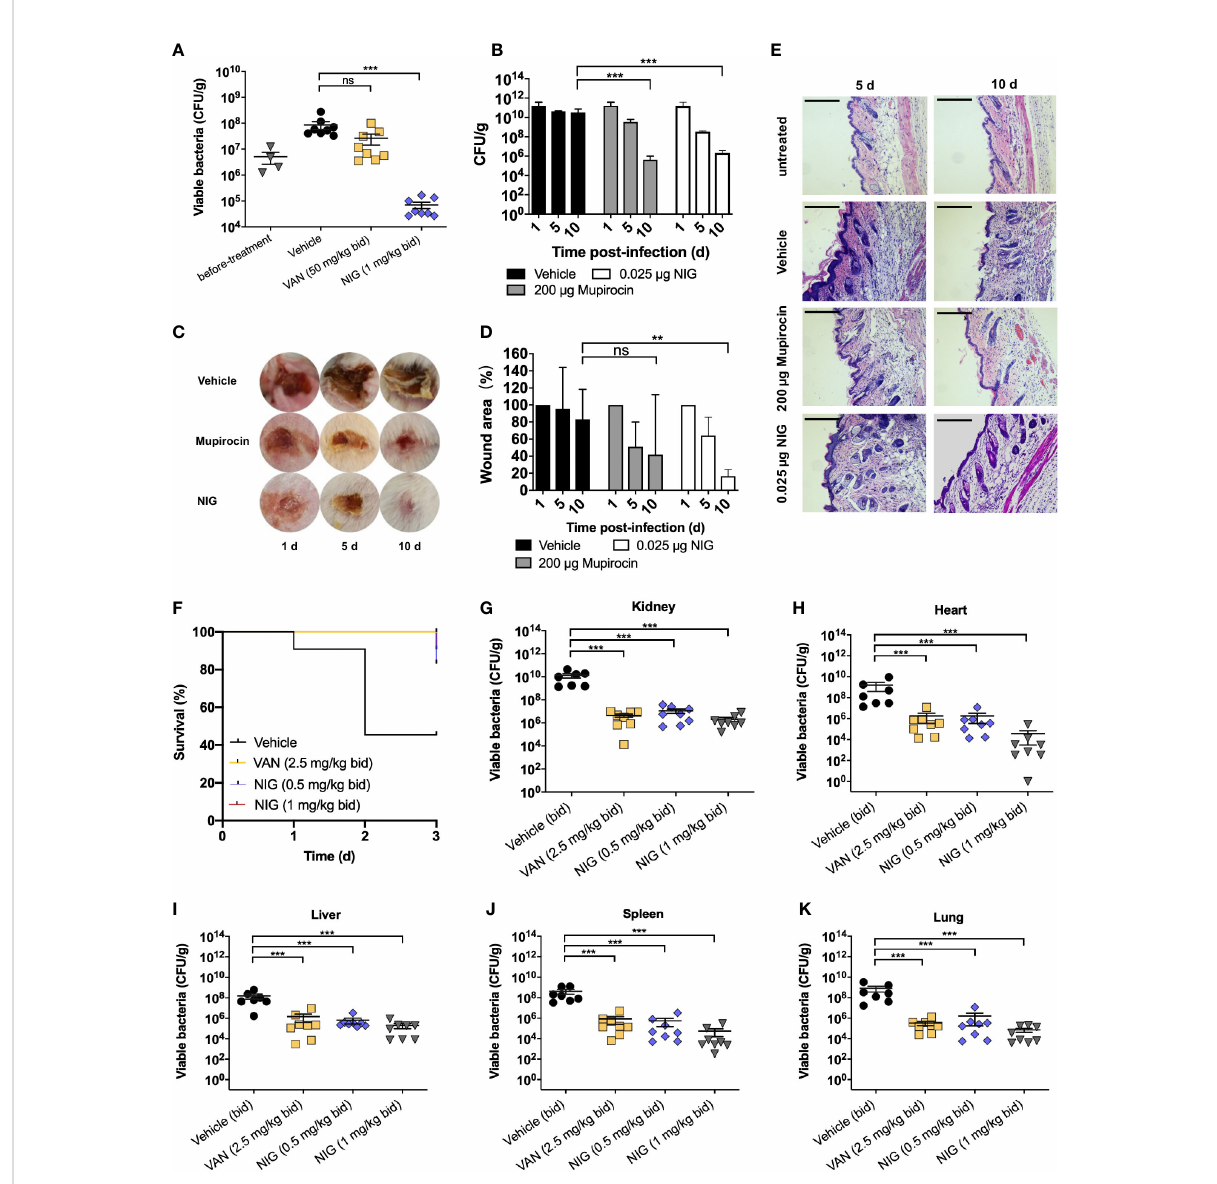
FIGURE 3 Nigericin ef fi cacy for treatment of S. aureus infection. (A) Deep-seated mouse bio fi lm infection model using S. aureus strain USA300 (n = 8). After acclimation, mice were subjected to thigh injection of 5 × 10 7 CFU of stationary-phase S. aureus USA300. Starting 24 h after infection, mice were treated twice daily with vancomycin (VAN, 50 mg/kg), nigericin (NIG, 1 mg/kg), or vehicle (20% (w/v) Kolliphor ® HS 15) for 3 days. Bacterial burden in thigh was determined after 3 days of treatment. (B – E) Trauma infection model using S. aureus strain USA300 (n = 5). After acclimation, mice were subjected to subcutaneous wound generation followed by infection (3 × 10 7 CFU/wound) of S. aureus strain USA300. Starting 24 h post-infection, topical daily treatment with nigericin (0.025 m g per wound), mupirocin (200 m g per wound), or a vehicle control was carried out for 9 days. Samples were taken at days 1, 5, and 10 for analysis presented in panels (B – E) . (B) Wound viable bacterial count. Wound tissues were dissected, homogenized, serially diluted, and plated on agar for enumeration of viable bacteria. (C) Visualization of wounds at indicated times after initiation of treatment. (D) Wound areas were measured. (E) Wound histopathology was recorded. Skin portions were harvested, sectioned, and stained with H&E. They were then examined by light microscopy. Scale bar, 250 m m. (F-K) Murine blood infection using S. aureus USA300. After acclimation, mice were subjected to tail vein injection of 1 × 10 7 CFU of S. aureus USA300. Starting 4 h after infection, mice were treated twice daily with vancomycin (VAN, 5 mg/kg), nigericin (NIG, 0.5 mg/kg/1 mg/kg), or vehicle (20% (w/v) Kolliphor ® HS 15) for 3 days. Animal survival was monitored daily and presented in (F) . Animals in the vehicle (control) arm were so sick at day 3 that they were subjected to euthanasia. Bacterial burden in various organs was determined after 3 days of treatment and presented in panels (G)